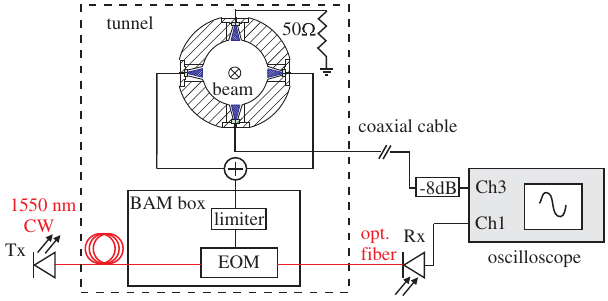
FIG. 6. Measurement setup for the pickup signal extraction utilizing the BAM front end and a real time